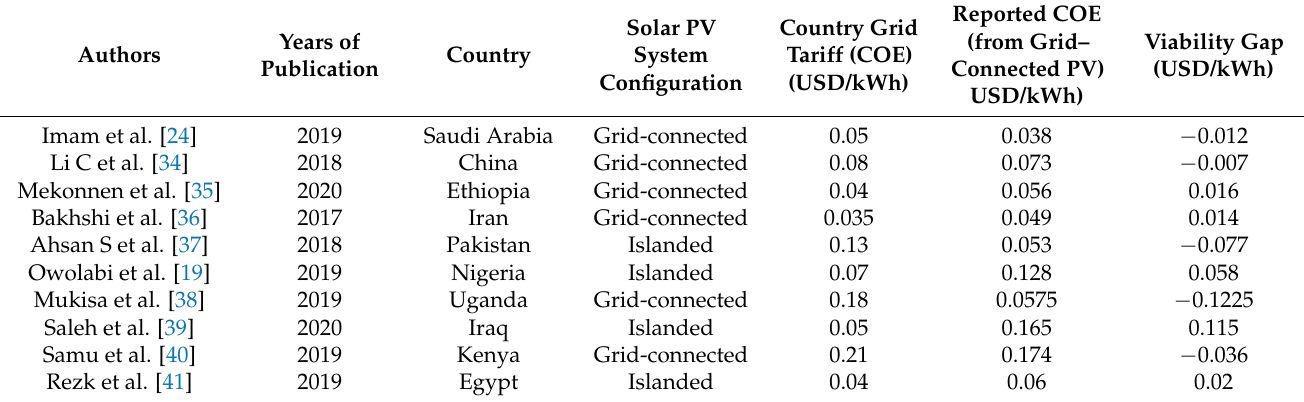
Table 1. Economic viability gap (cost of energy (COE)) of solar PV microgrids from the grid in some